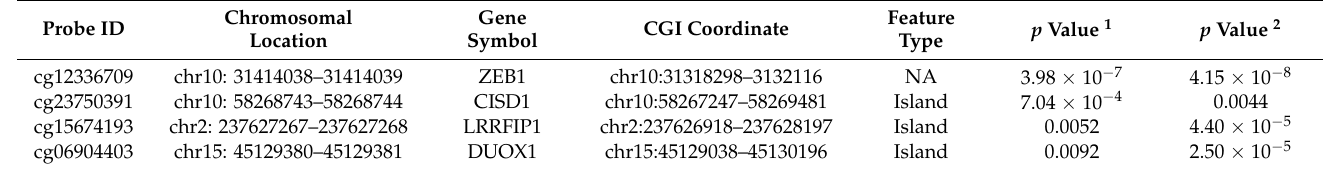
Figure 1. The forest plots of univariate and multivariate cox regression about four FRG DNA methylation site in the TCGA cohort. ( A ) Forest plots of univariate Cox regression analysis using single methylation levels at four DNA methylation sites as variables, respectively. ( B ) Forest plots of Multivariate Cox regression analysis using methylation levels at four DNA methylation sites as covariates. The forest plot was generated to show the connection between four FRG DNA methylation sites and the OS of CM patients. Table 1. Four significantly survival-related FRG DNA methylation sites in TCGA dataset.